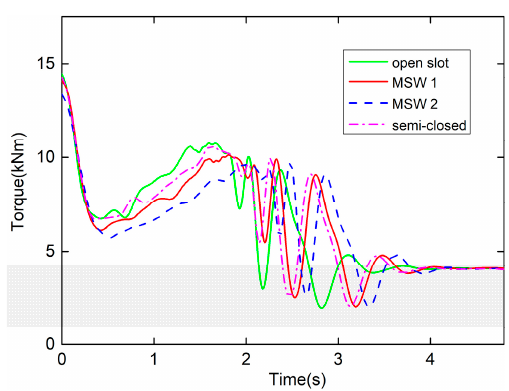
Figure 17. Torque vs. time.